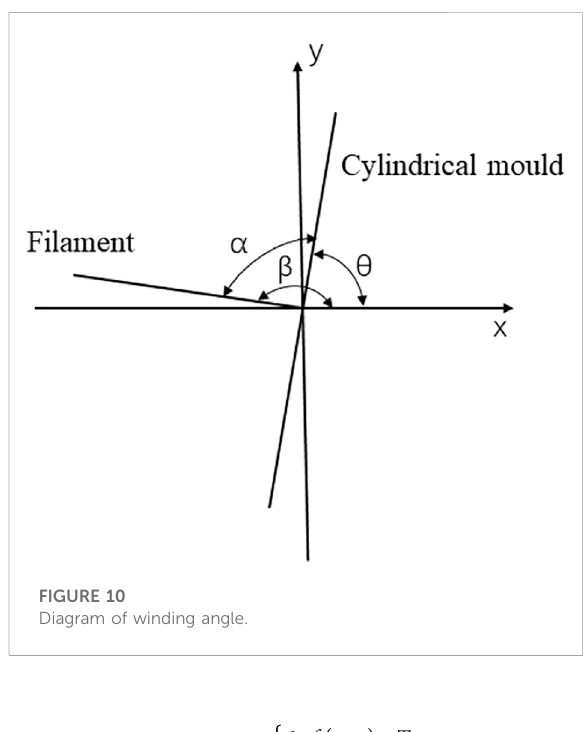
FIGURE 10 Diagram of winding angle.